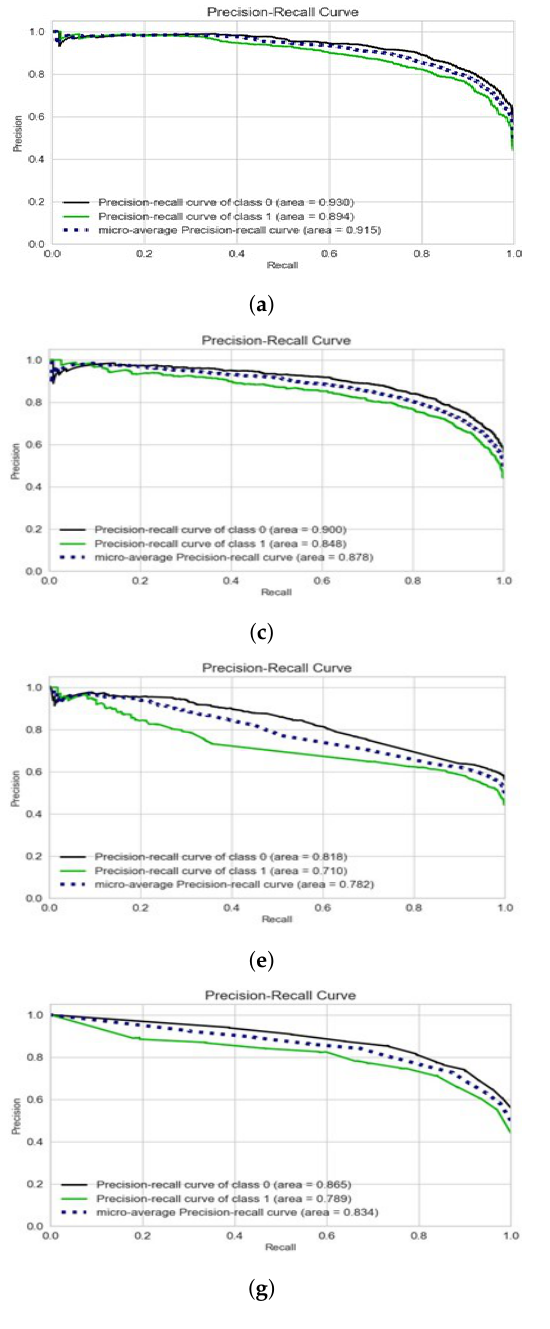
Figure 12. Precision–Recall curves for the proposed algorithms at highest accuracy level in each case. ( a ) SVM (Tfidf + unigrams). ( b ) Naïve Bayes (Tfidf + unigrams). ( c ) Logistic regression (Tfidf + unigrams). ( d ) Decision tree (unigrams + trigrams). ( e ) AdaBoost (unigrams + trigrams). ( f ) Xboost (Tfidf + unigrams). ( g ) Bagging classifier (Tfidf +